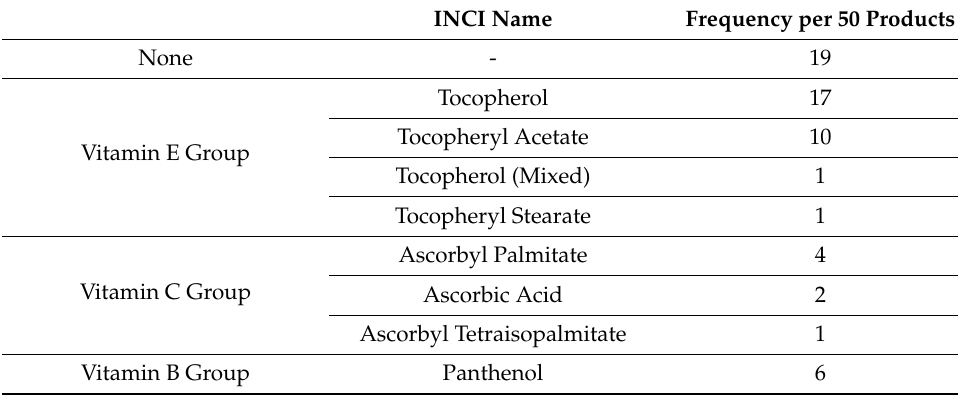
Table 2. Frequency of vitamins in the analyzed abrasive cosmetics products.